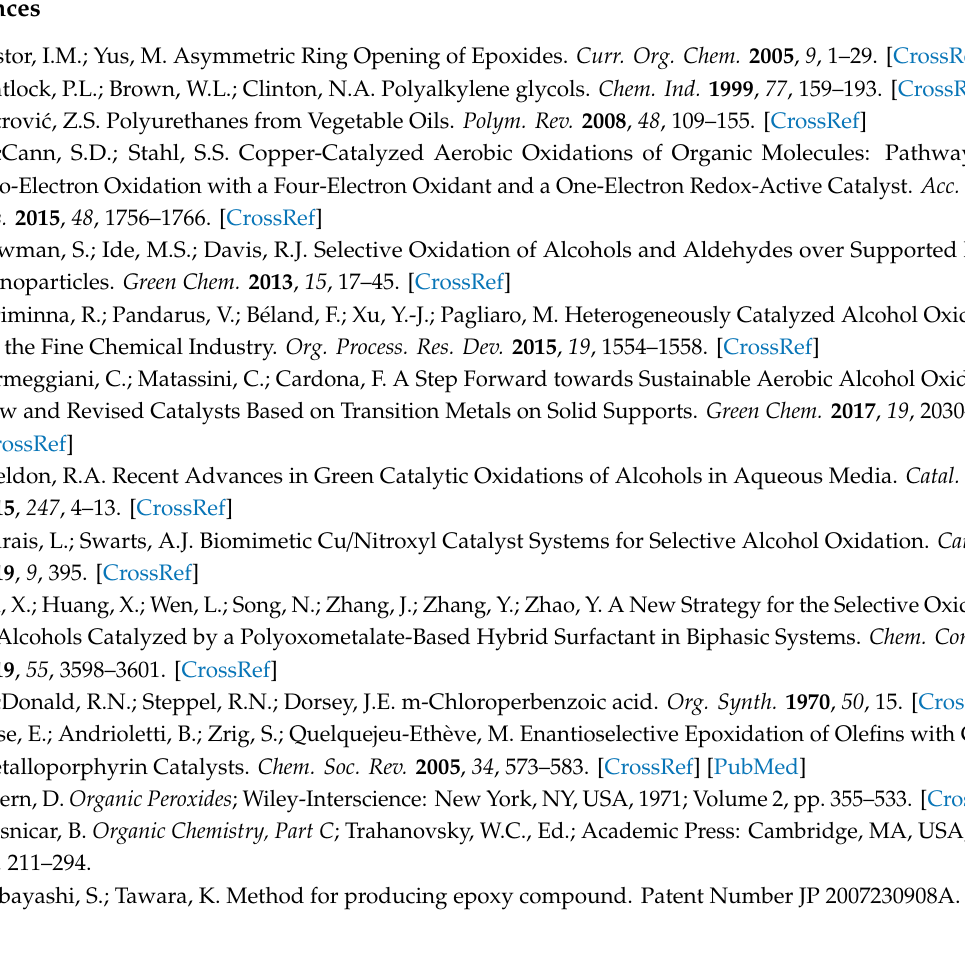
Figure S2 : Comparison of Powder X-ray di ff ractions of (a) H 3 PMo 12 O 40 (orange) and SiO 2 @PMo (blue) and (b) H 3 PW 12 O 40 (orange) and SiO 2 @PW (blue). The intensities of SiO 2 @PMo and SiO 2 @PW were magnified 10 times. Figure S3 : From up to down: Relevant IR vibration zones for SiO 2 , SiO 2 @NH 2 , SiO 2 @PW , SiO 2 @PMo . Figure S4 : Di ff erence spectra ( SiO 2 @NH 2 - SiO 2 ) on specific ranges (in blue). The spectrum of APTES is indicated in orange Table S1 : Relevant solid-state NMR data. Figure S5 : 13 C MAS NMR spectra of SiO 2 @PW (up), SiO 2 @PMo (middle) and SiO 2 @NH 2 (down). Figure S6 : 29 Si MAS NMR spectra of SiO 2 (a) SiO 2 @NH 2 (b), SiO 2 @PW (c) and SiO 2 @PMo (d). Appendix A1- Determination function coverage of functionalized silica beads. Figure S7 : Evolution of CO ( (cid:52) ) and COE ( (cid:78) ) with SiO 2 @PW (Run 1 (a), Run 2 (b) and Run 3 (c)) and SiO 2 @PMo (Run 1